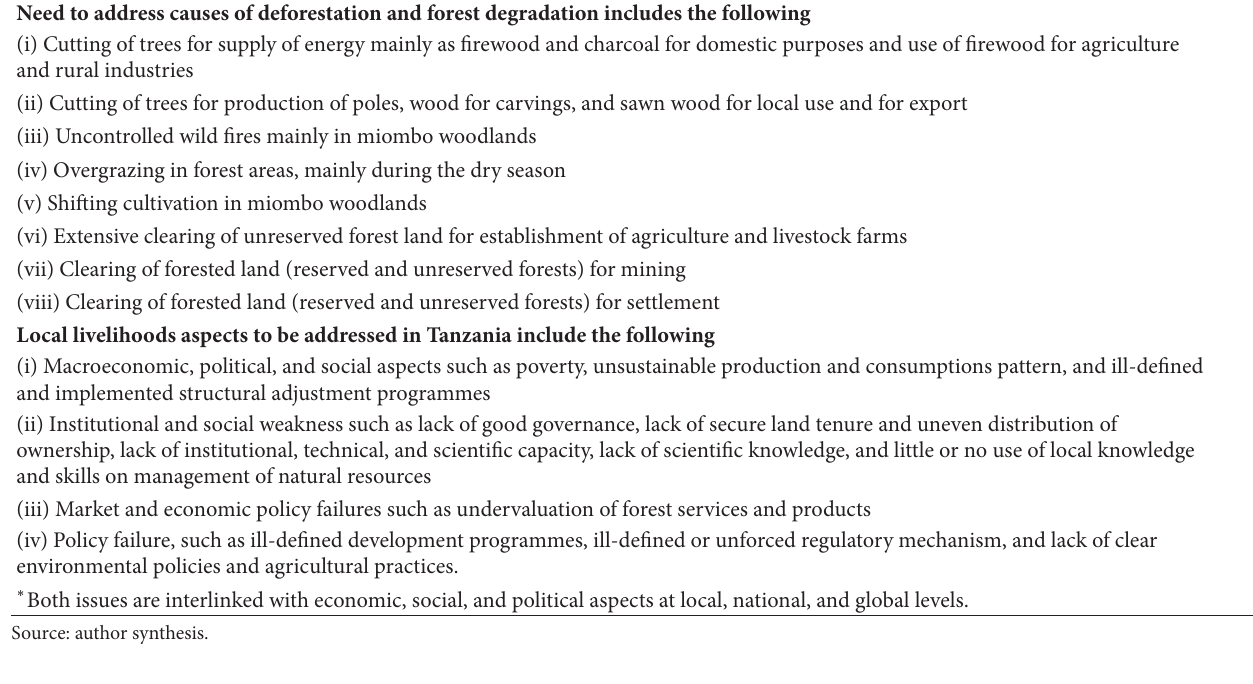
Table 8: Important issues for climate change mitigation and local livelihoods